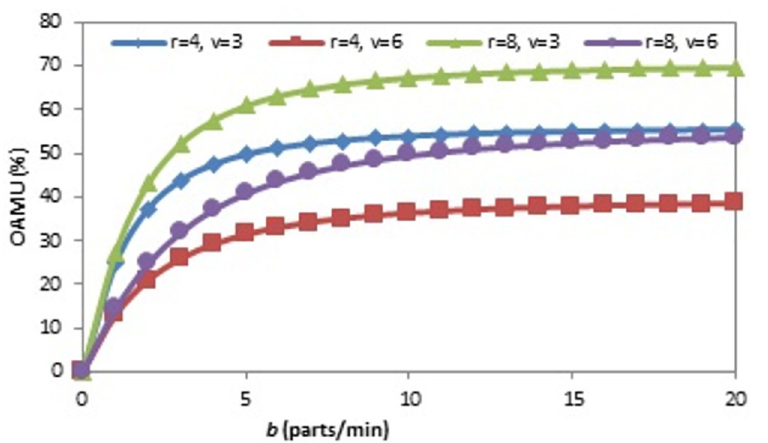
Fig 5. OAMU-b diagram for single-machine